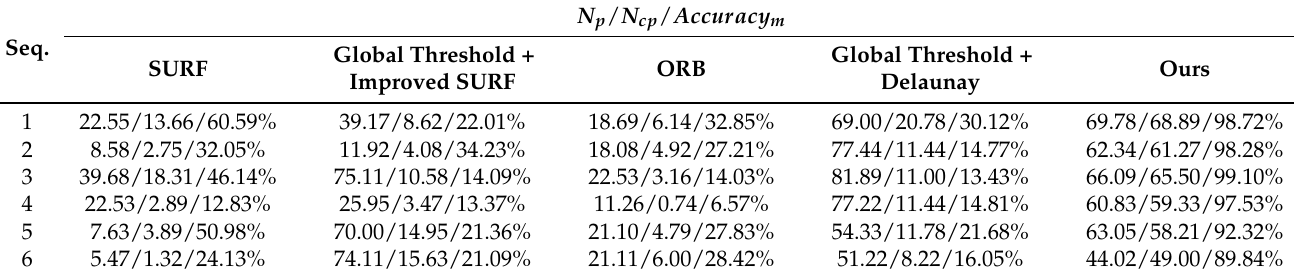
Table 4. Comparison of corresponding point-matching among the proposed method and baselines.